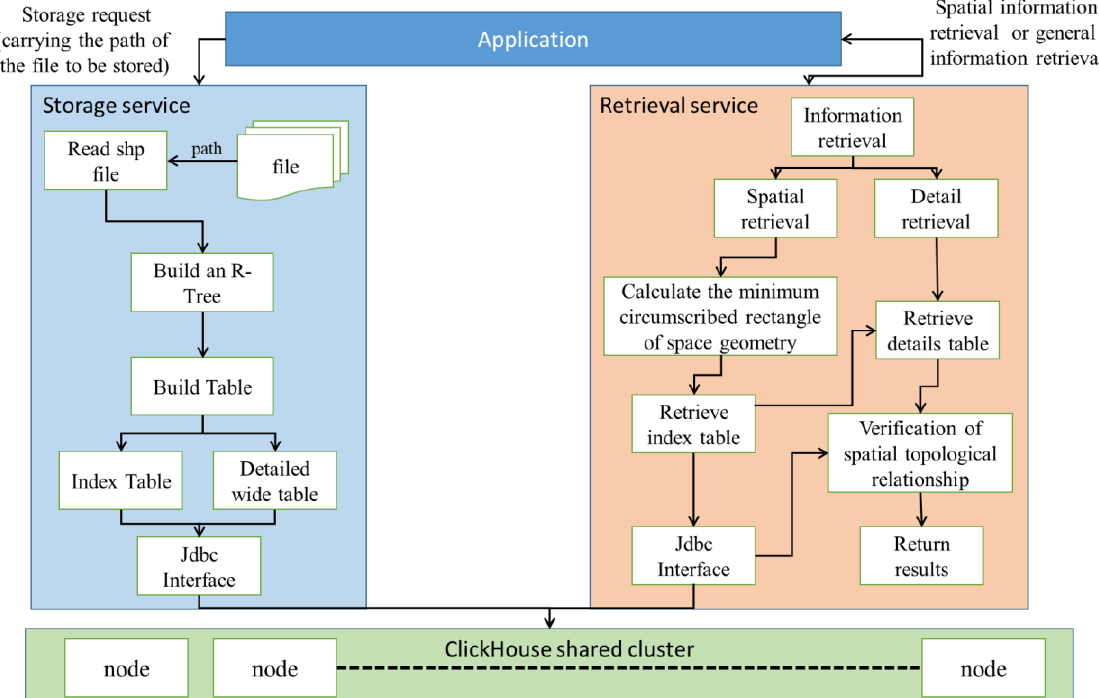
Figure 1 . The overall architecture of ClickHouse for storing and retrieving geospatial